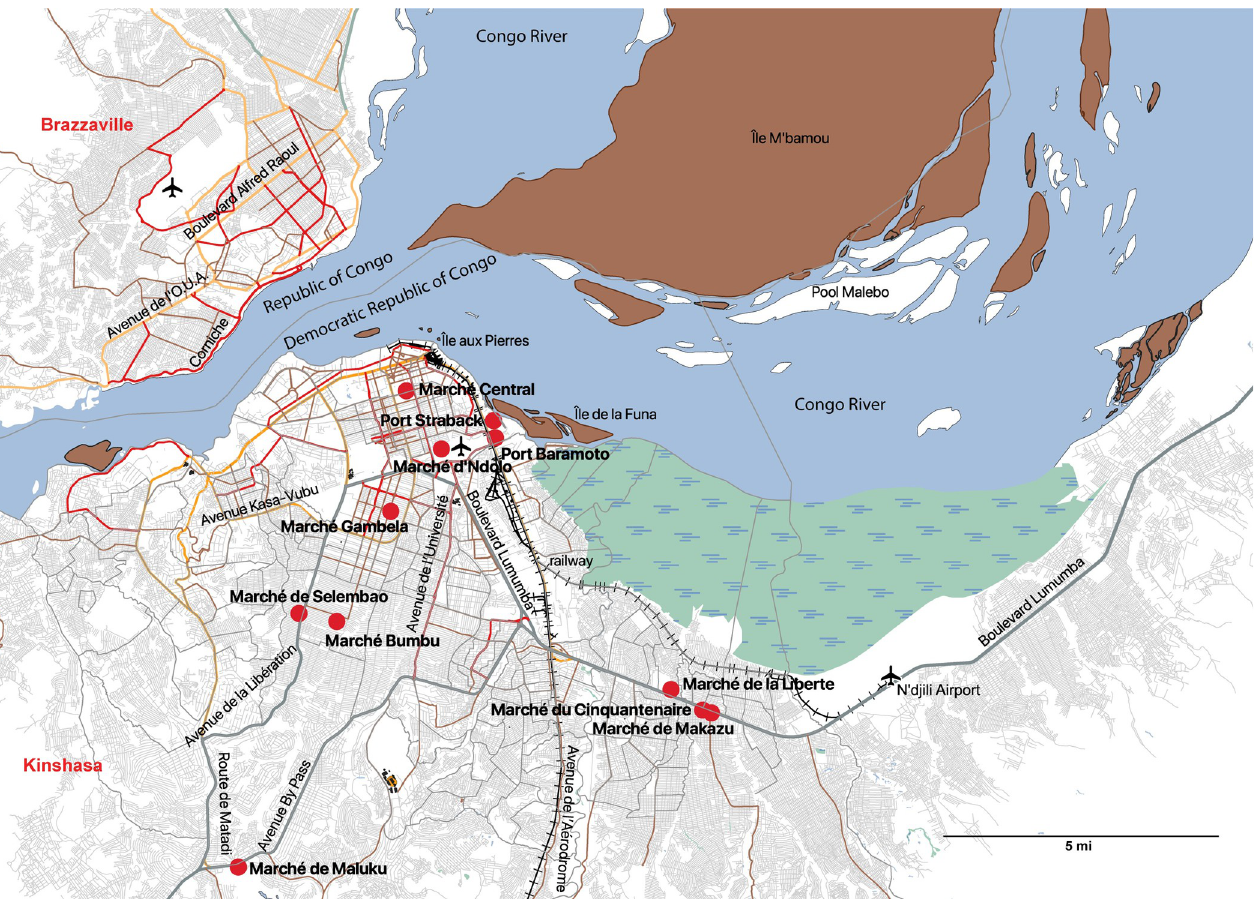
Fig 1. Map of Kinshasa study sites. Included are bushmeat markets where sampling occurred, main road arteries, location of the International airport, the Congo river and border designation between Democratic Republic of Congo and Republic of Congo. Base map and data from OpenStreetMap and OpenStreetMap Foundation, which is made available under the Open Database